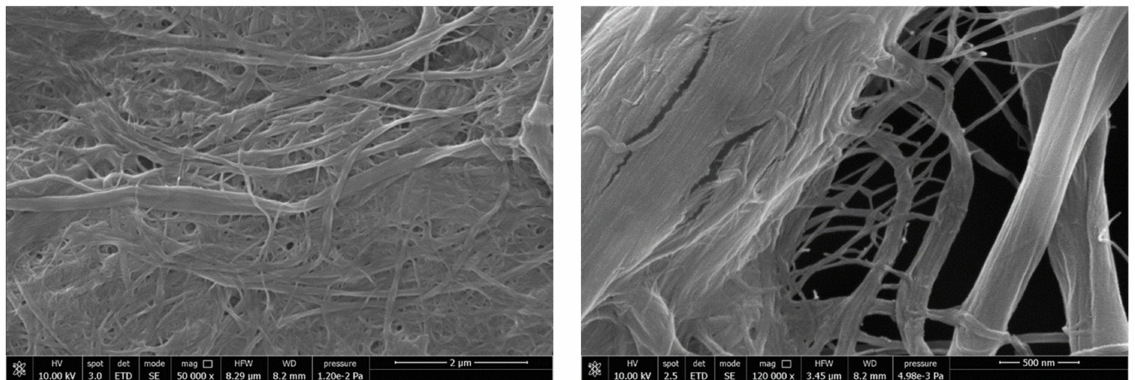
Figure 4. Morphology of the Celish–micro fibrillated cellulose (MFC) sample.